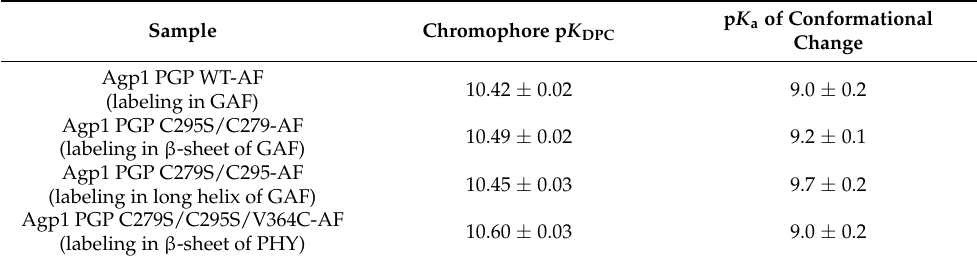
Table 3. Comparison of p K a values of biliverdin chromophore deprotonation (p K DPC ) of the different AF-labeled Agp1-PGP variants and the p K a values of protein conformational changes in the different domains. The standard error is given ( ±